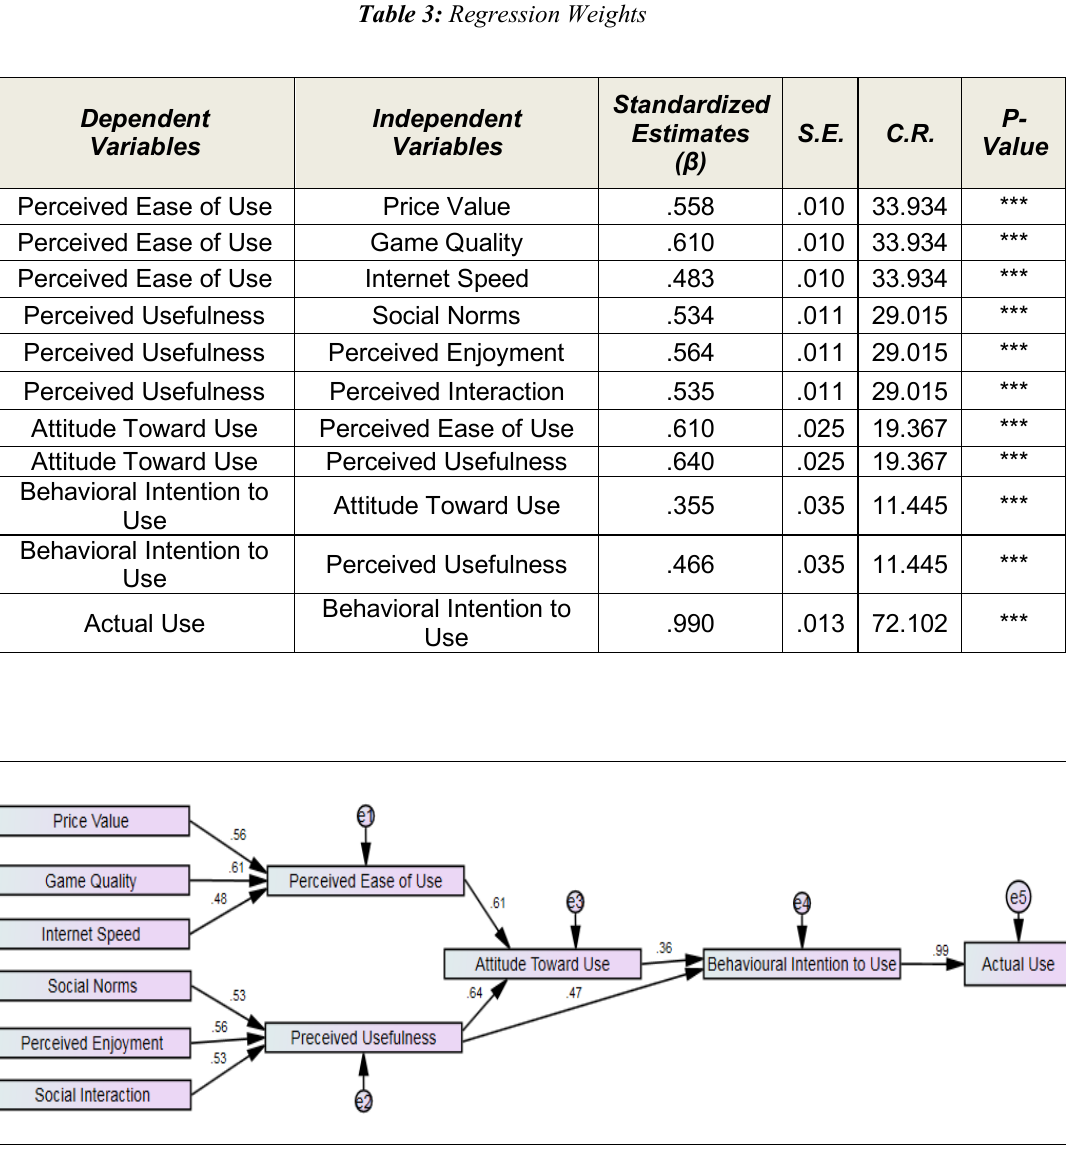
Figure 2: Research Path